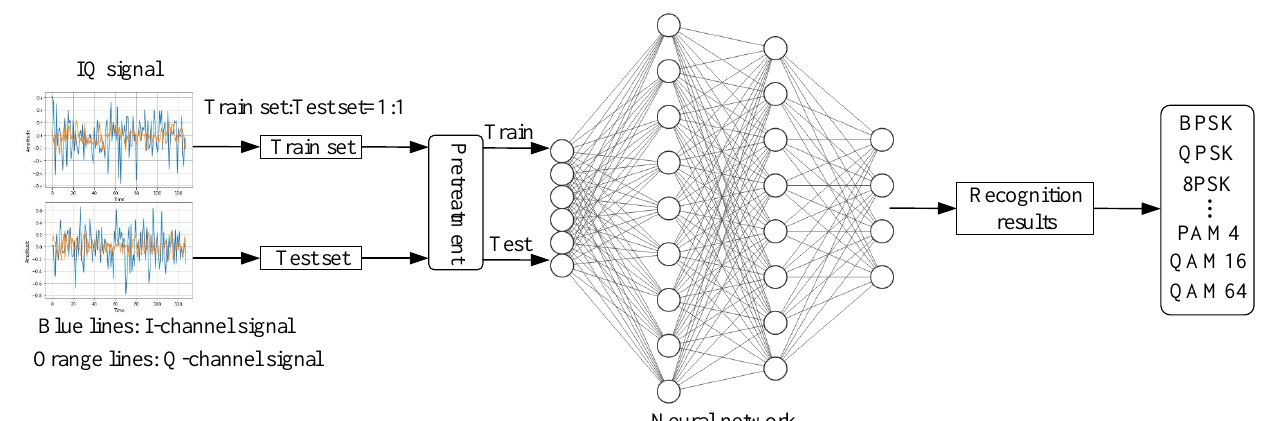
Figure 6. Flow chart of CNN-based AMR method.